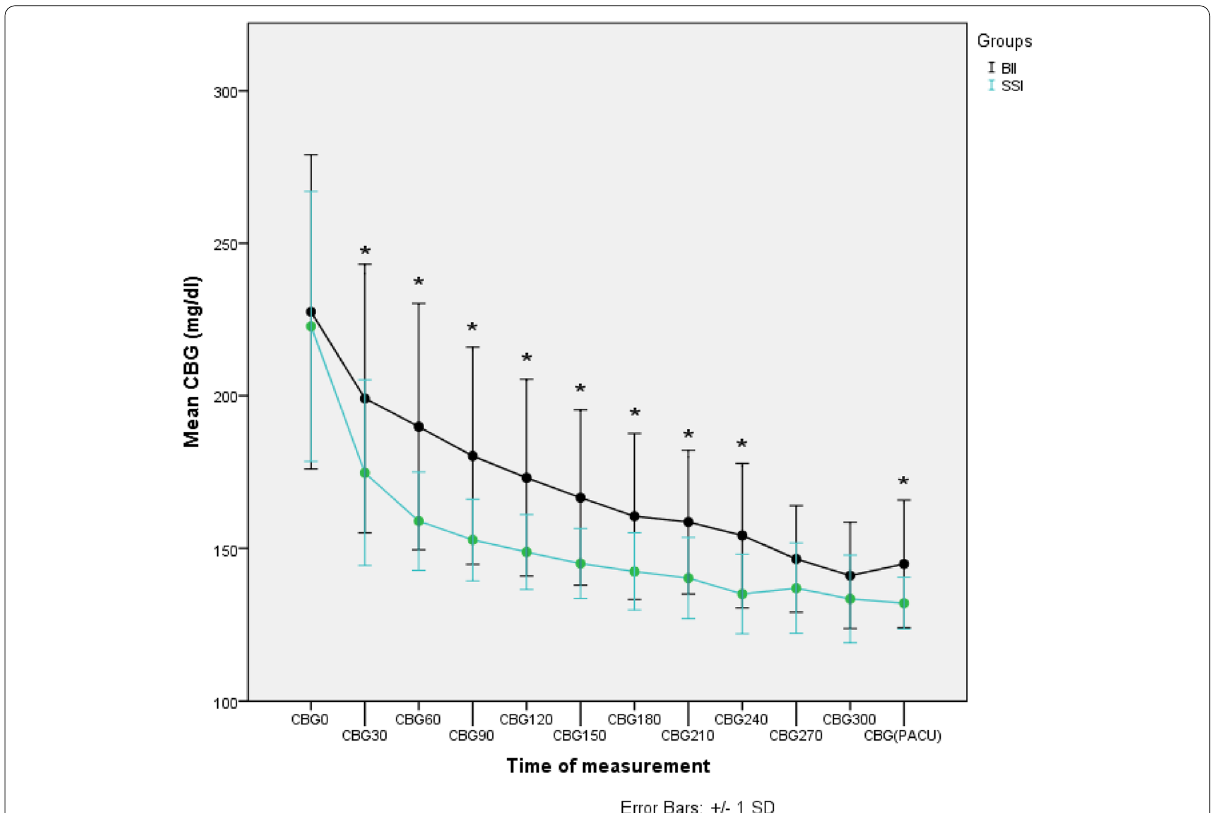
Fig. 3 The mean CBG at different times of measurement. Data are presented as mean Bolus‑insulin infusion group, SSI: Sliding scale of insulin group, CBG: Capillary blood glucose, PACU: Post anesthesia care unit